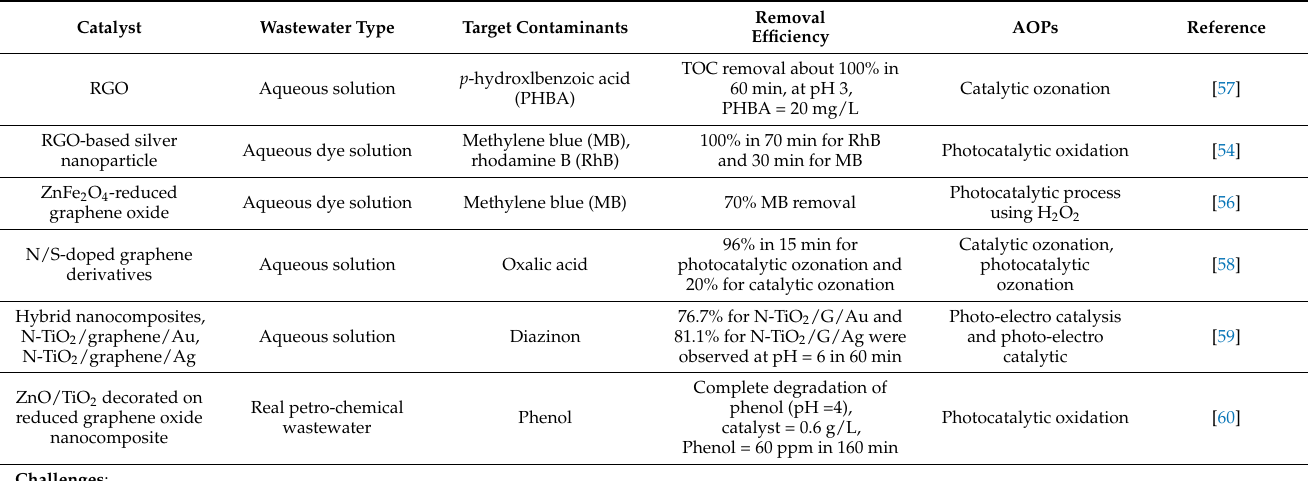
Table 4. Graphene and its modified forms as a catalyst used in AOPs for wastewater treatment.